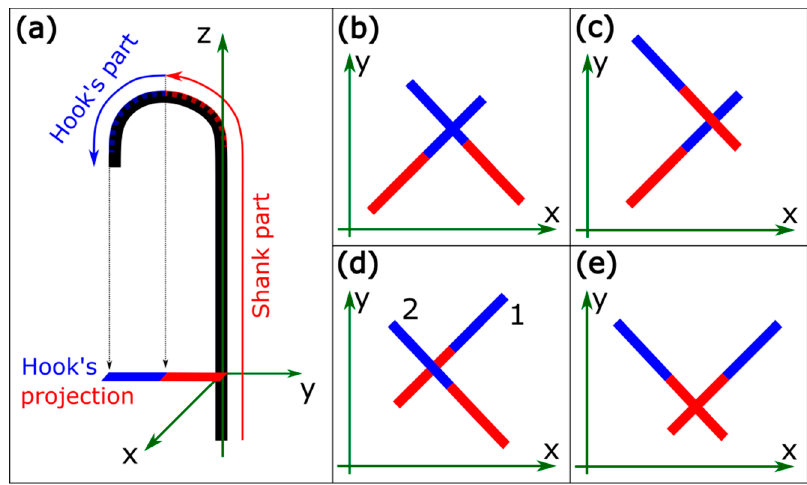
Figure 4. Schematics of individual parts of a NiTi hook and their projections in plane xy ( a ) and four variants of intersections of two hook projections ( b – e ). In ( a ), the hook and shank’s parts are the ascending and descending parts, respectively.